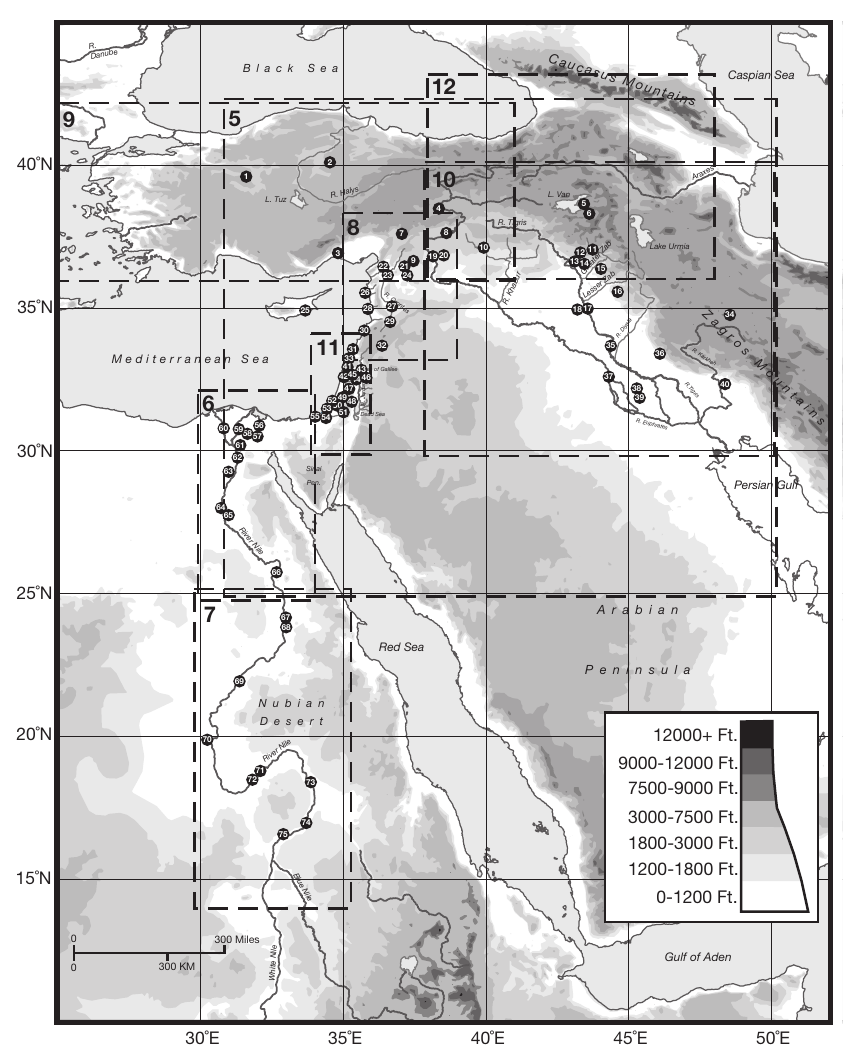
Figure 4 – The Field of Action of Central Civilization Figure 3 – Civilization/World System Power